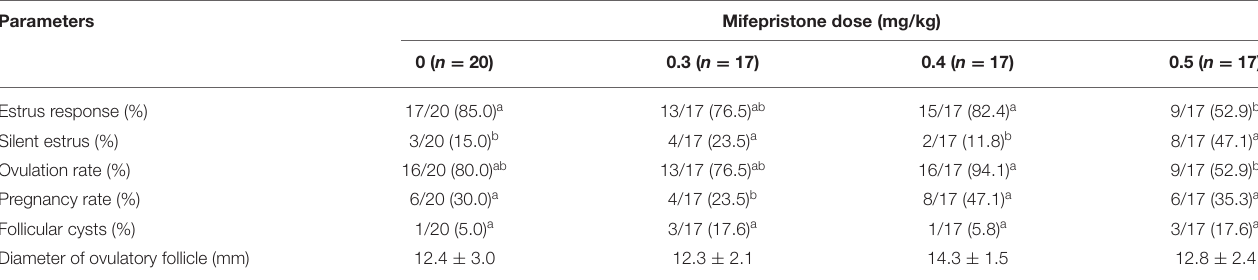
TABLE 2 | Effect of different doses of mifepristone (0, 0.3, 0.4, and 0.5 mg/kg) on estrus, ovulation, and pregnancy rate of buffaloes synchronized by GPGMH protocol during breeding season. Parameters